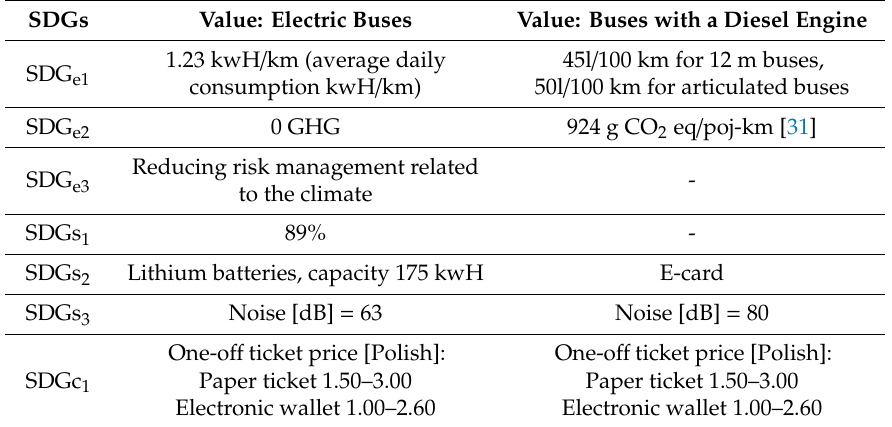
Table 3. Comparison of the value of SDGs in the city of Zielona G ó ra between electric buses and diesel